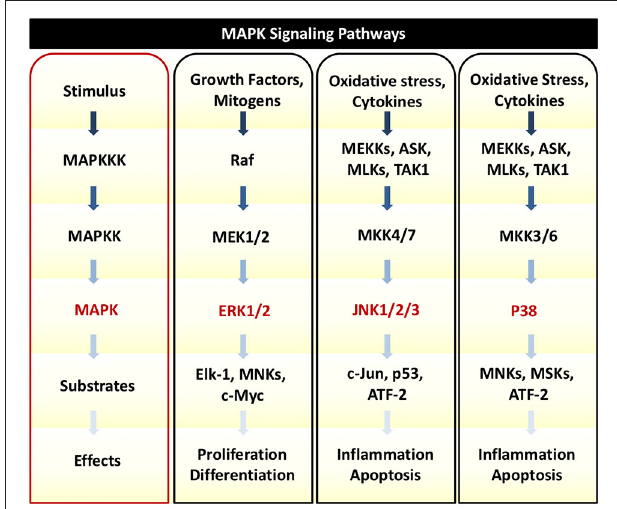
FIGURE 3 | MAPK Signaling . There are three tiers of protein kinases that comprise each family of MAPKs: (1) MAPK; (2) MAPK kinase (MAPKK); and (3) MAPKK kinase (MAPKKK). Following a specific stimulus, MAPKKK phosphorylates and activates MAPKK, which then phosphorylates and activates MAPK to then phosphorylate target substrates that can regulate cellular proliferation, survival, inflammation, and cell death. The three main classes of MAPK include ERK1/2, JNK1/2/3, and p38. Oxidative stress and cytokines such as TNF α can trigger JNK and p38 to phosphorylate downstream transcription factors that initiate pro-death and pro-inflammatory signaling and gene transcription.